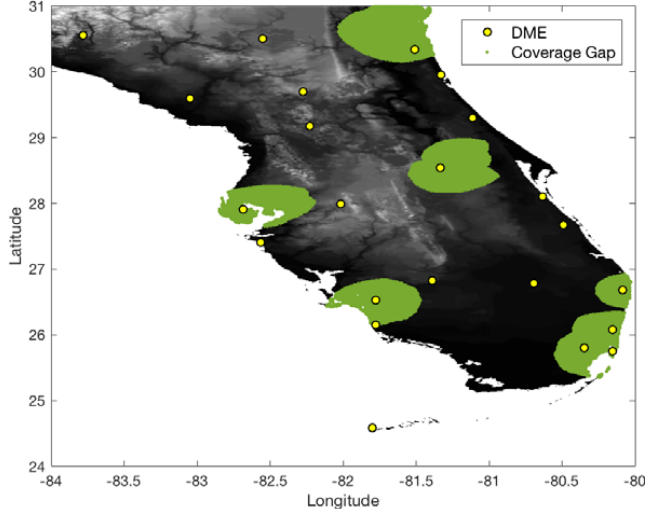
Figure 8. DME/DME positioning accuracy gaps of 0.3 nm with legacy DME and the current DME ground network.